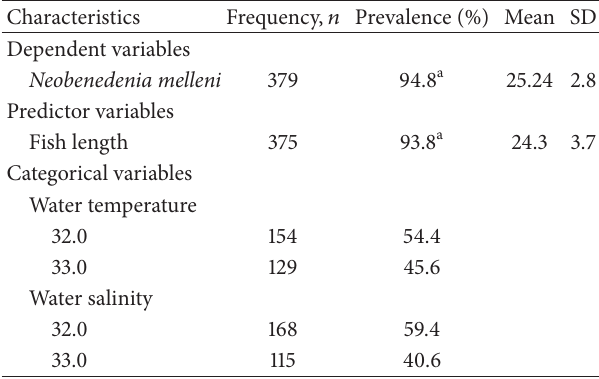
Table 1: The table shows the descriptive statistics of dependent and predictor